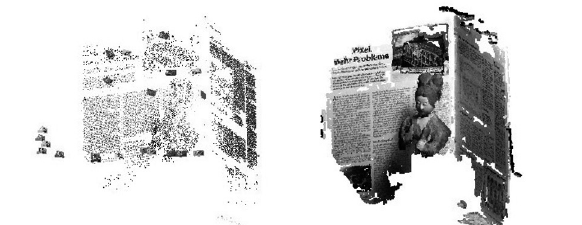
Figure 7: Comparison between sparse and dense point cloud